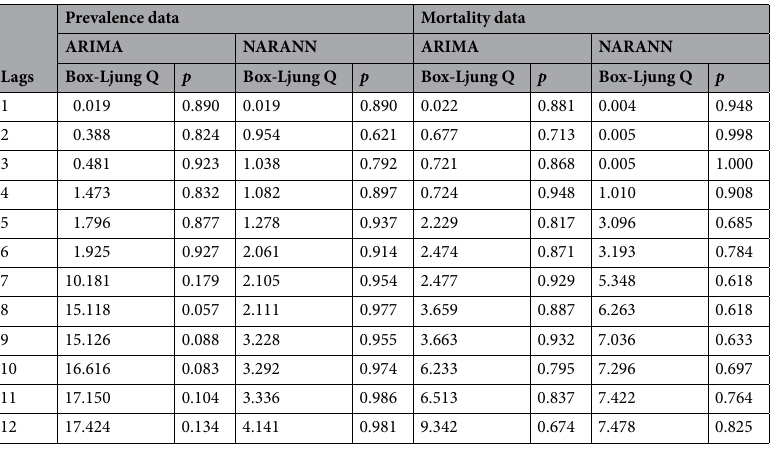
Table 3. Box-Ljung Q test for the residual series from the best ARIMA and NARANN models. ARIMA Autoregressive integrated moving average method, NARANN nonlinear autoregressive artificial neural